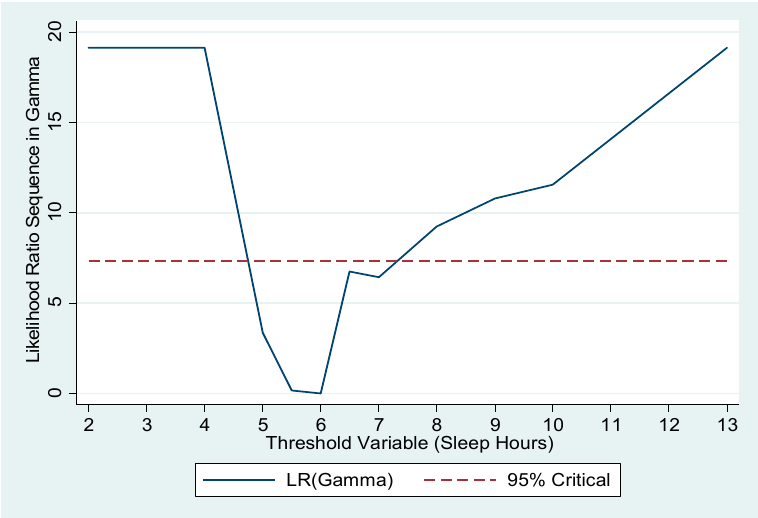
Figure 2. Estimated threshold of sleep duration and its confidence interval. The solid line is the likelihood ratio sequence along different values of the threshold variable (sleep duration) and the dashed line is the critical value for a 95% confidence level. The confidence interval for the threshold is the collection of values below the dashed line. Table 1. General characteristics of study participants and comparisons of sleep duration subgroups.